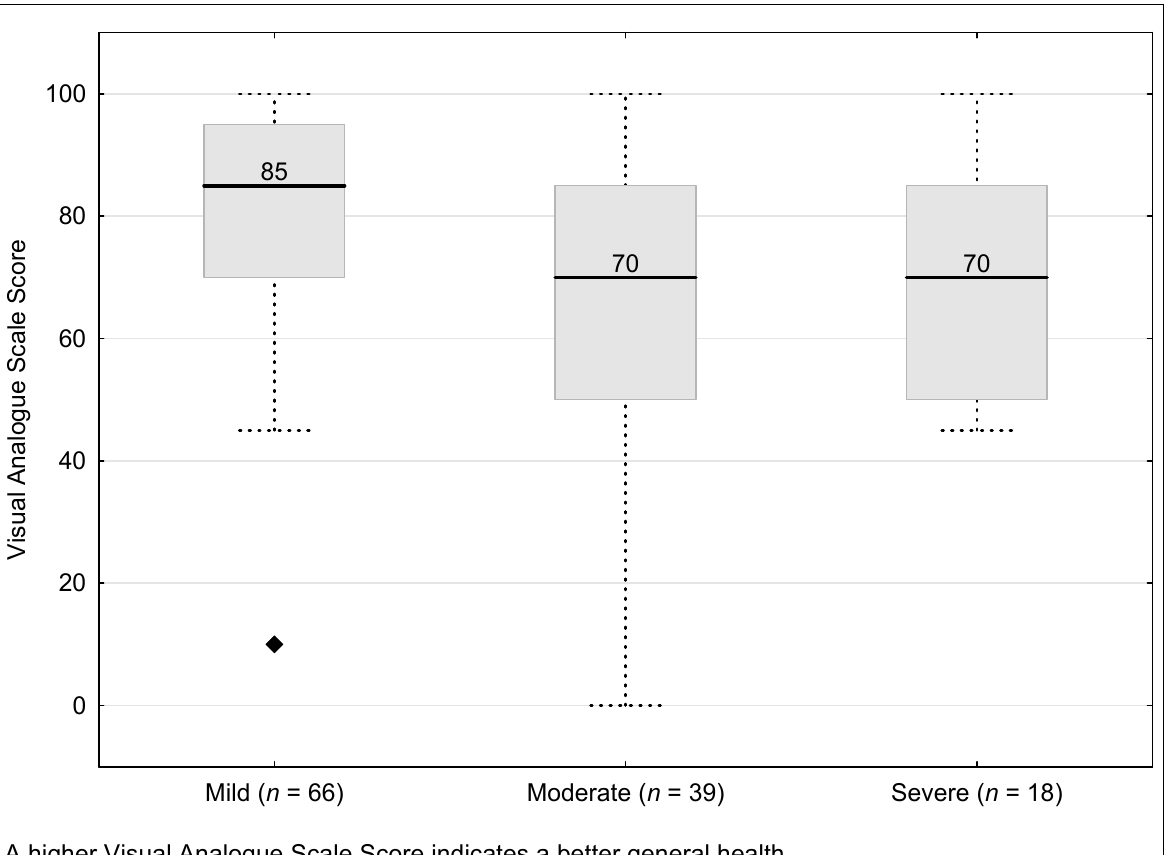
Figure 3. Discriminate validity of the TANDI Visual Analogues Scale score across severity of health condition. (Total Sample N = 203). Health condition indicates attendance at a paediatric hospital for management of an acute or chronic health condition. Boxes indicate first to third quartiles, the dividing line the median, whiskers the non-outlier range and markers the outliers.